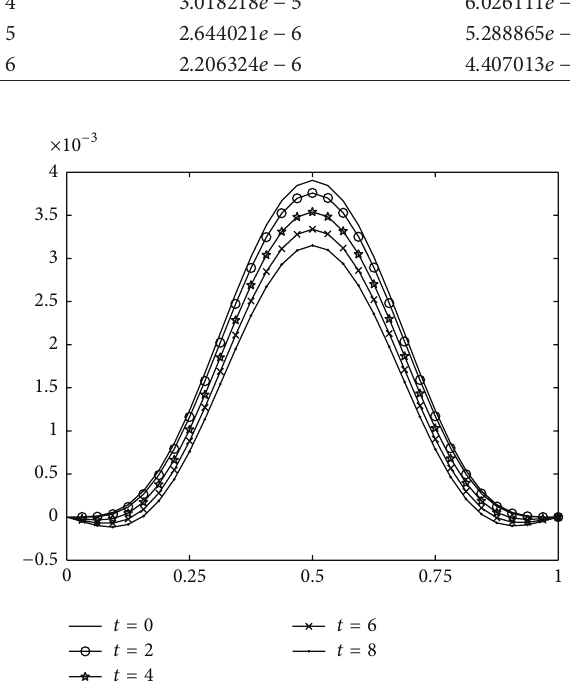
Figure 4: Numerical solutions at 𝑡 = 10 , ℎ = 1/32 , 𝜏 = 0.1 , 𝛽 = 1 , 𝛼 = 4 , and 𝑝 = 8 .